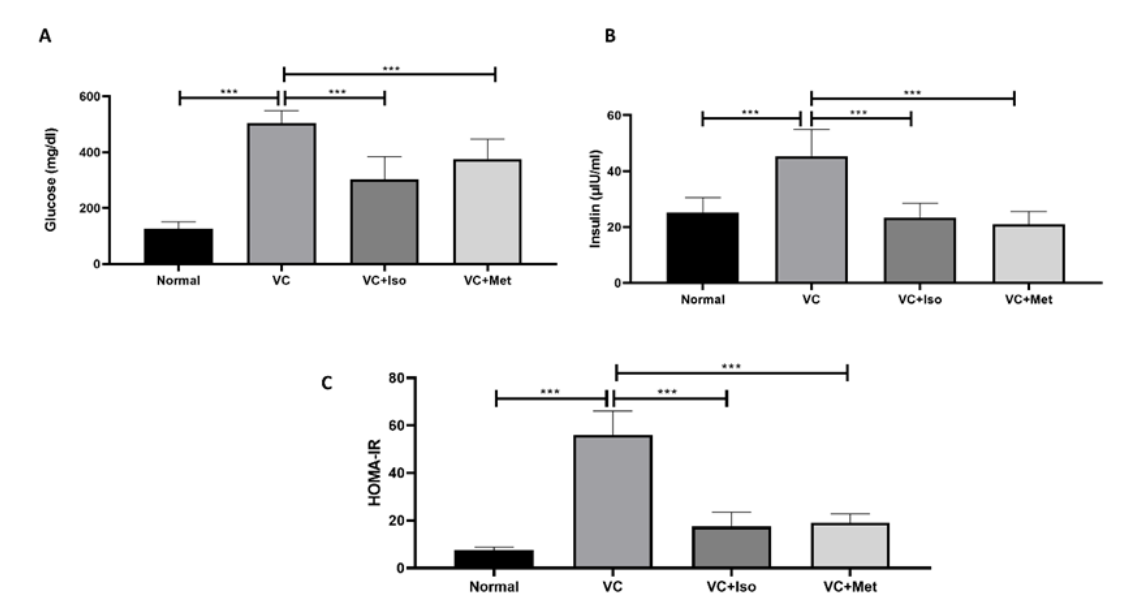
Figure 1. The anti-diabetic effect of isorhamnetin. Isorhamnetin significantly reduced glucose ( A ) and insulin ( B ) levels in diabetic mice. HOMA-IR ( C ) was significantly reduced with isorhamnetin treatment. Mice were fed with HFD for 8 weeks followed by two low doses of STZ injection (40 mg/kg) after diabetes confirmed, mice were treated with 10 mg/kg isorhamnetin or 200 mg/kg metformin for 10 days, mice were then sacrificed, and serum collected for ELISA analysis. One-way ANOVA followed by Tukey post hoc, *** p < 0.001. VC; vehicle control, Iso; isorhamnetin, Met;